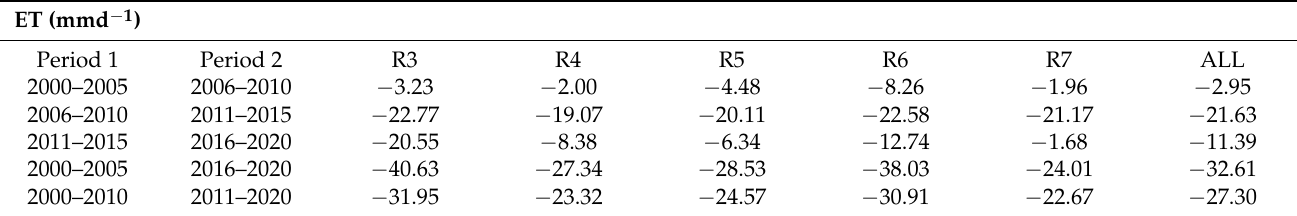
Table 3. ET (mmd − 1 ) percentage change by period, 5-year or 10-year, for each reach and All reaches with all riparian vegetation water use along the Lower Colorado River being negative ( − ) change and demonstrating decreases in ET between the first and second